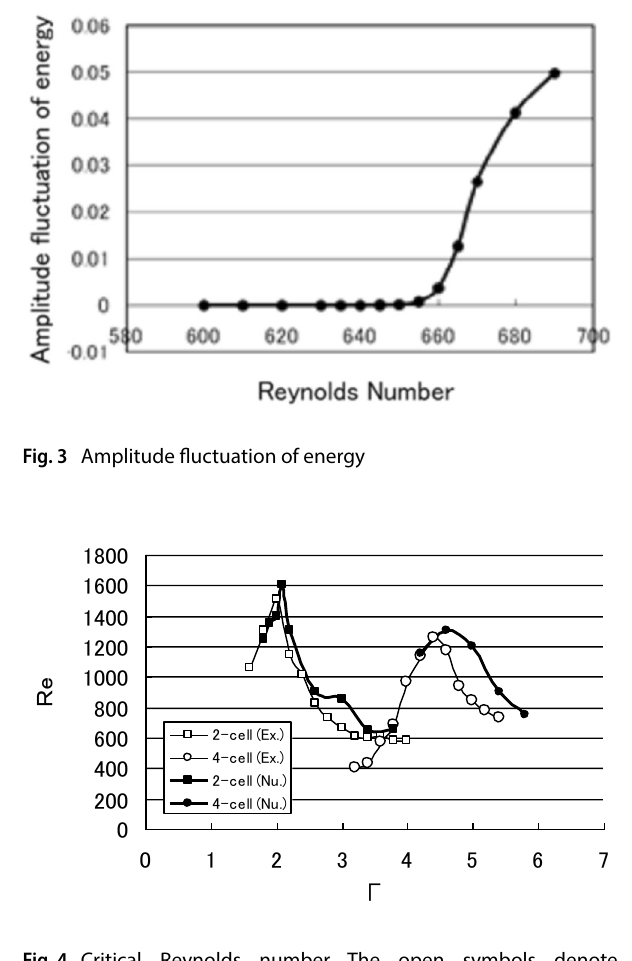
Fig. 4 Critical Reynolds number The open symbols denote the experimental results, and the filled symbols represent the numerical results. The square and circle symbols indicate the 2-vortex and the 4-vortex flows